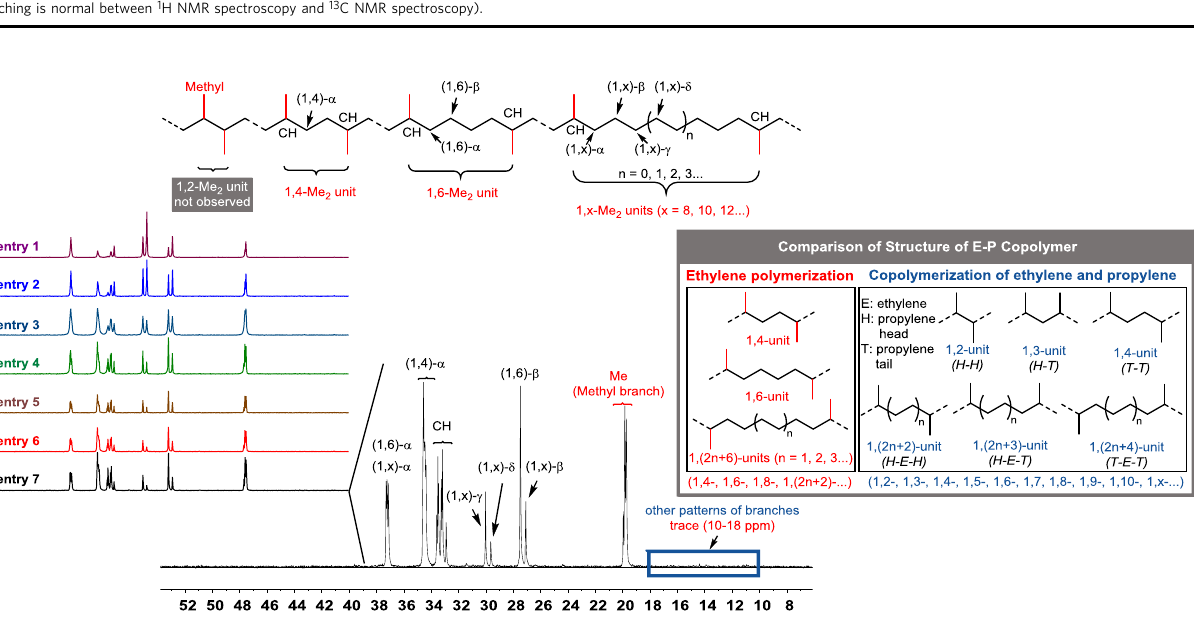
Fig. 3 13 C NMR spectra and an in-depth analysis of branch pattern and distribution. 13 C NMR spectra (400 MHz, C 2 D 2 Cl 4 , 110 °C) of highly branched polyethylenes come from Table 1, entire 1 – 7 and the in-depth analysis comes from Table 1, entry 7 (205 branches/1000 C). Comparison on